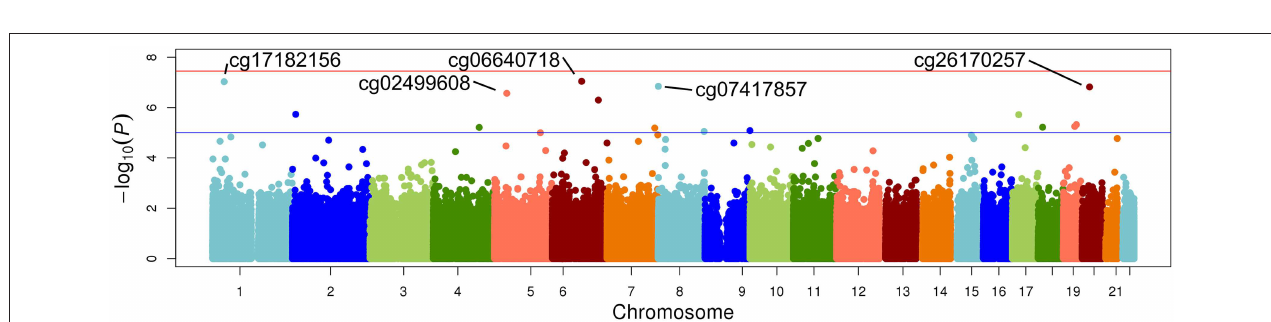
FIGURE 1 | Epigenome-wide Manhattan plot for change in DNA methylation by change in triglycerides after 3 weeks of daily fenofibrate (160mg).